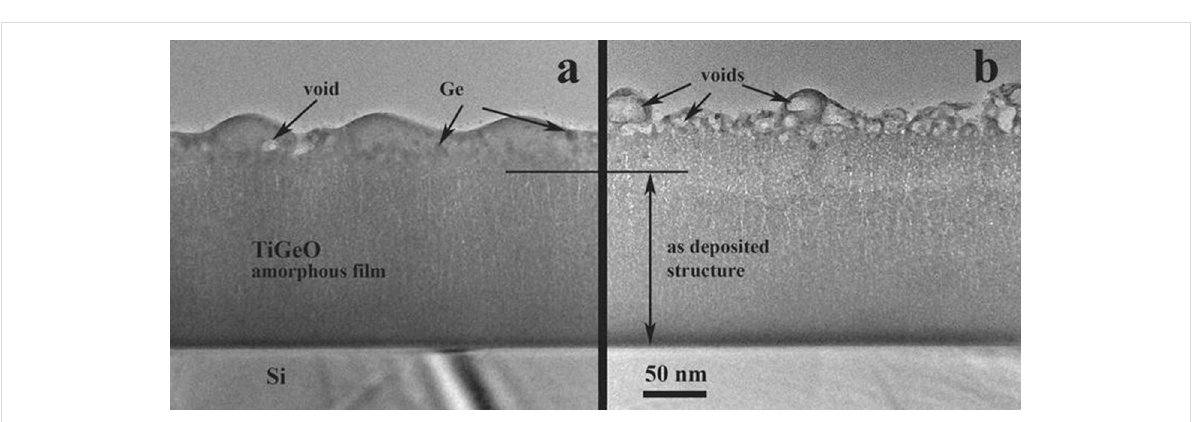
Figure 3: XTEM images of the amorphous GeTiO RF film after laser irradiation with 266 nm laser radiation. (a) Low fluence (15 mJ/cm 2 ) and (b) higher laser fluence (20 mJ/cm 2 ). The film structure morphology is transformed in a depth of about 50